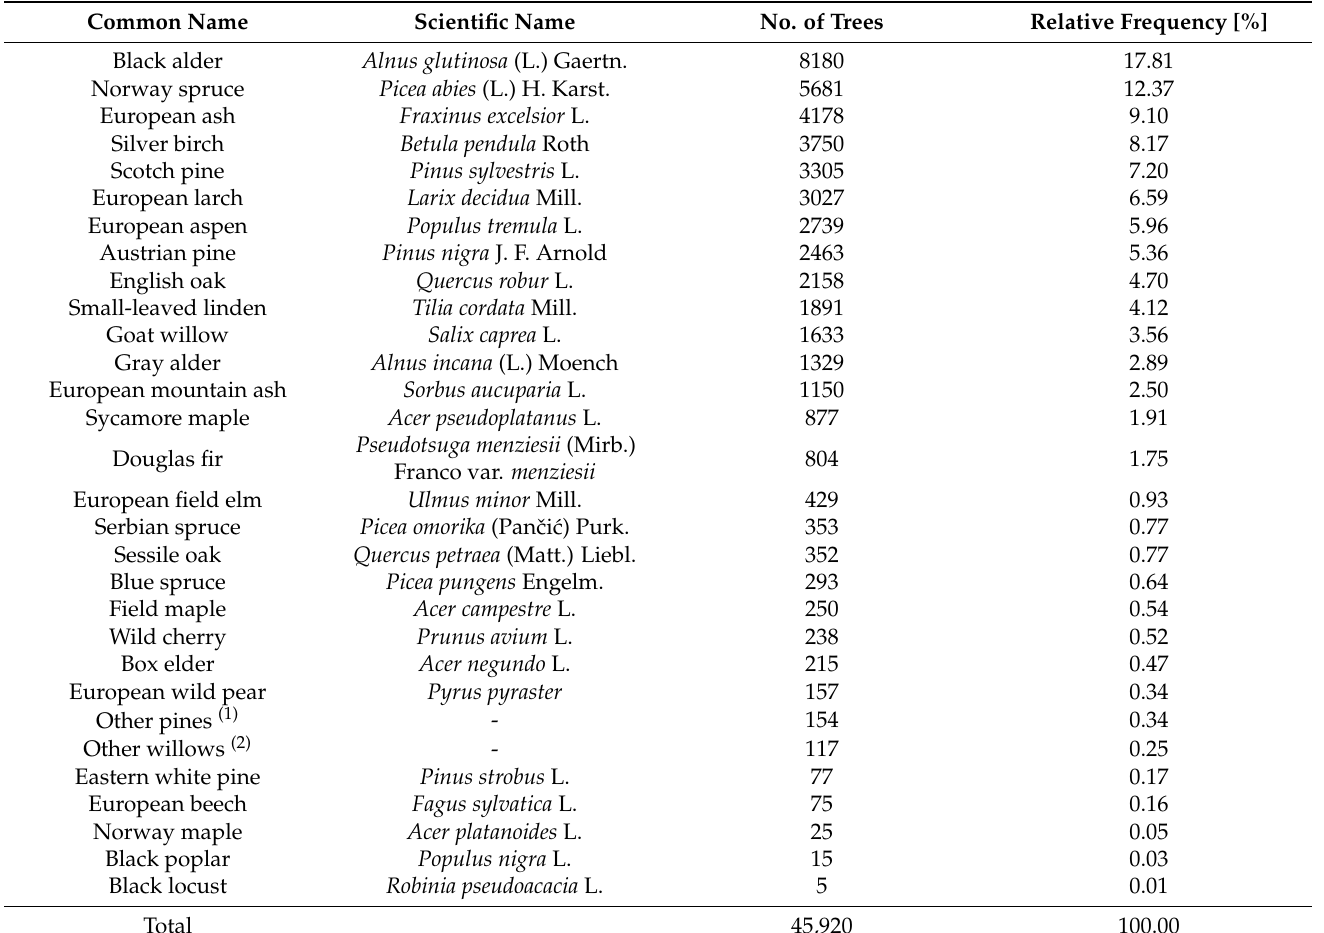
Table A1. Relative frequencies of tree species growing on the inventory plots of the Maty á š a Velk á Podkrušnohorsk á spoil